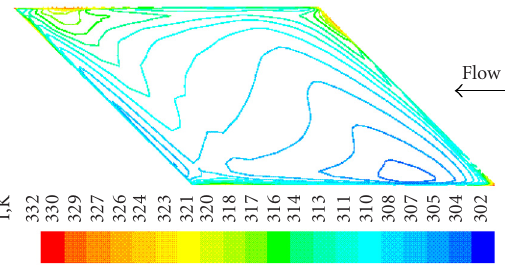
Figure 10: Representative isotherms on the surface area between a pair of ribs.